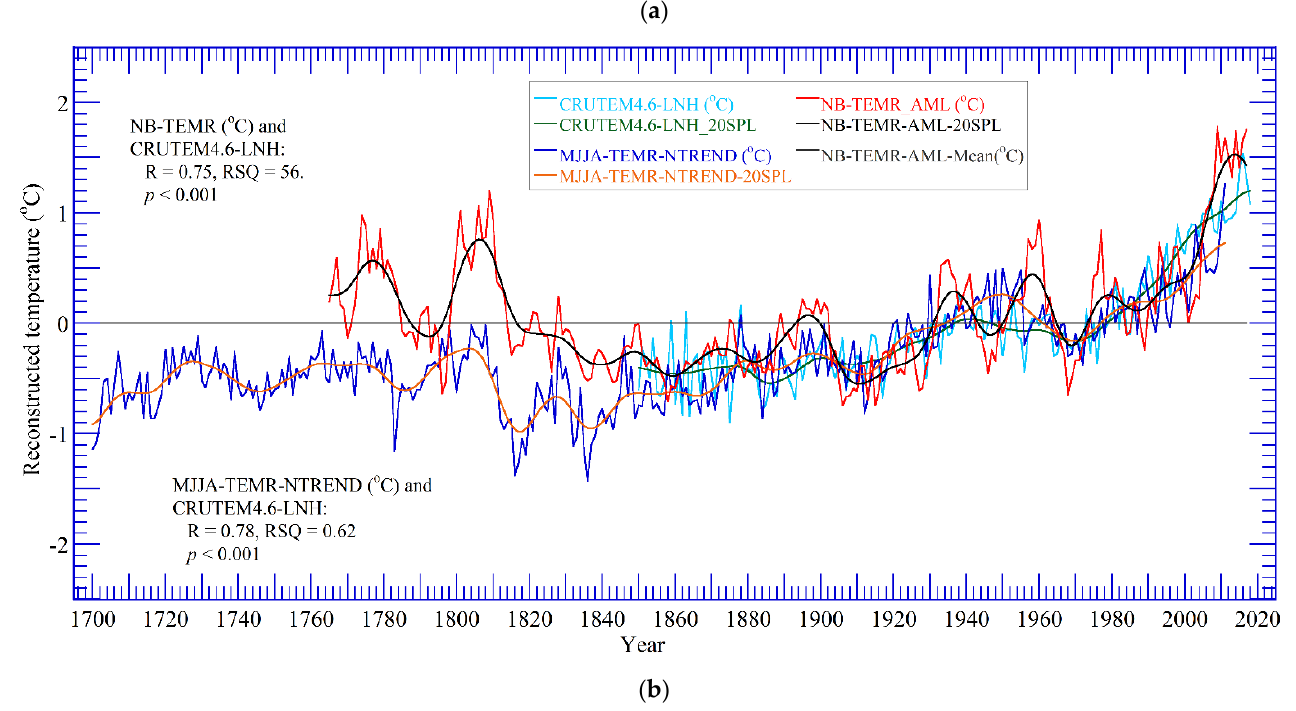
Figure 8. Comparison with two reconstructions and an instrumental record — Bhutan Himalaya and Extratropical Northern Hemisphere. ( a ) NB − TEMR (red with black spline line) with JJA − TEMR-BT13 (lime with purple spline line) and CRUTEM4.6 − LNH (cyan with green spline line). ( b ) NB − TEMR (red with black spline line) with MJJA − TEMR − NTREND (blue with orange spline line) and CRUTEM4.6− LNH (cyan with green spline line). Each reconstruction is represented as anomalies (°C) from 1901 – 2000 mean, 1881 – 1980 mean, and 1961 – 1990 mean (horizontal thick black line). Each reconstruction has been 20-year low pass filtered cubic smoothing spline.